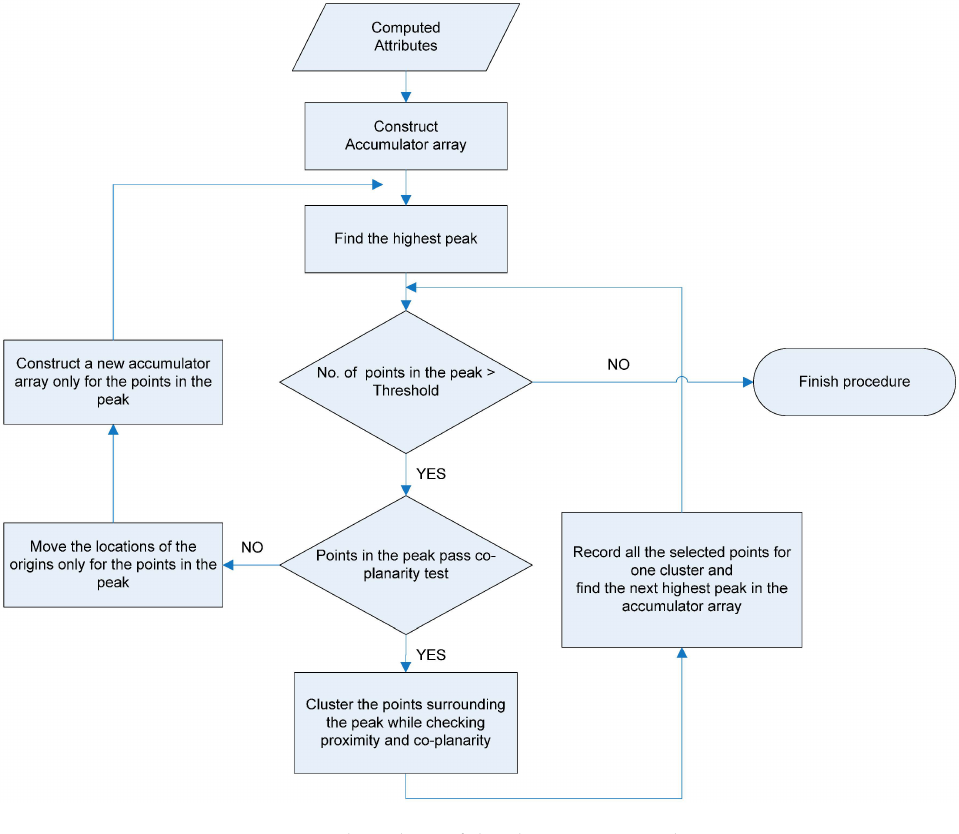
Figure 7. Flow chart of the clustering procedure.